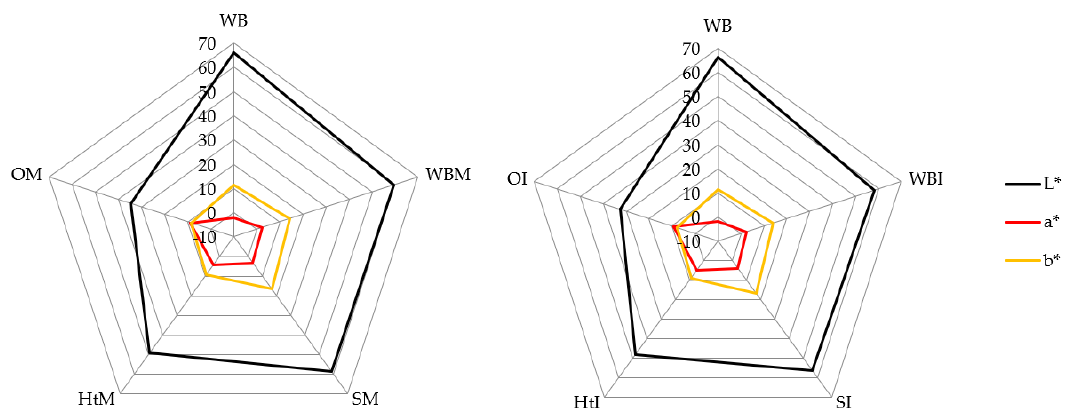
Figure 1. Color of different samples of wheat bread. Abbreviations: WB—wheat bread; WBM—wheat bread with maltodextrin; SM—wheat bread enriched with soy extracts in maltodextrin; HtM—wheat bread enriched with hawthorn extracts in maltodextrin; OM—wheat bread enriched with onion husk extracts in maltodextrin; WBI—wheat bread with inulin; SI—wheat bread enriched with soy extracts in inulin; HtI—wheat bread enriched with hawthorn extracts in inulin; OI—wheat bread enriched with onion husk extracts in inulin. The data are expressed as mean ( n = 3).